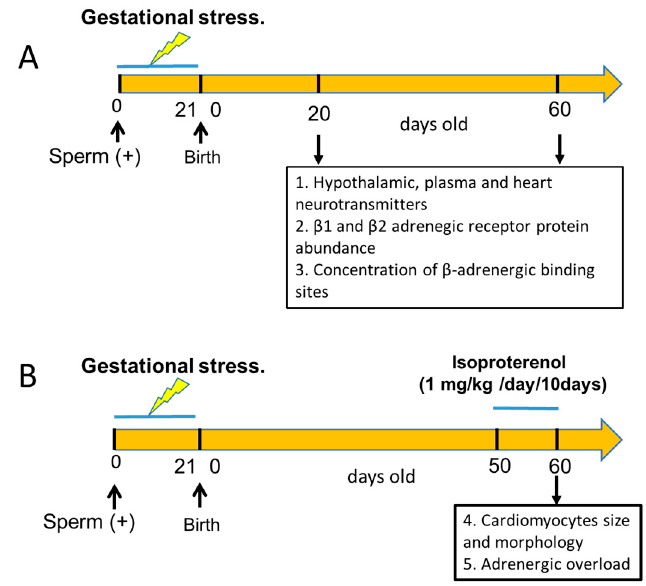
Figure 1. Schematic representation of the experimental groups used in the study. Group A was designed to study the effect of sympathetic gestational stress on the sympathetic neurotransmitter changes in the male progeny and its relationship with β -adrenergic receptor protein expression and the affinity of the β receptors to β ligands. In group B, we tested the effect of gestational stress on the development of cardiomyocytes in the adult heart and the response to an adrenergic overload with a β -agonist in vivo. In ( A , B ), we included an equivalent group of control rats that, when pregnant, were not exposed to gestational stress, and the progeny was used as a control.